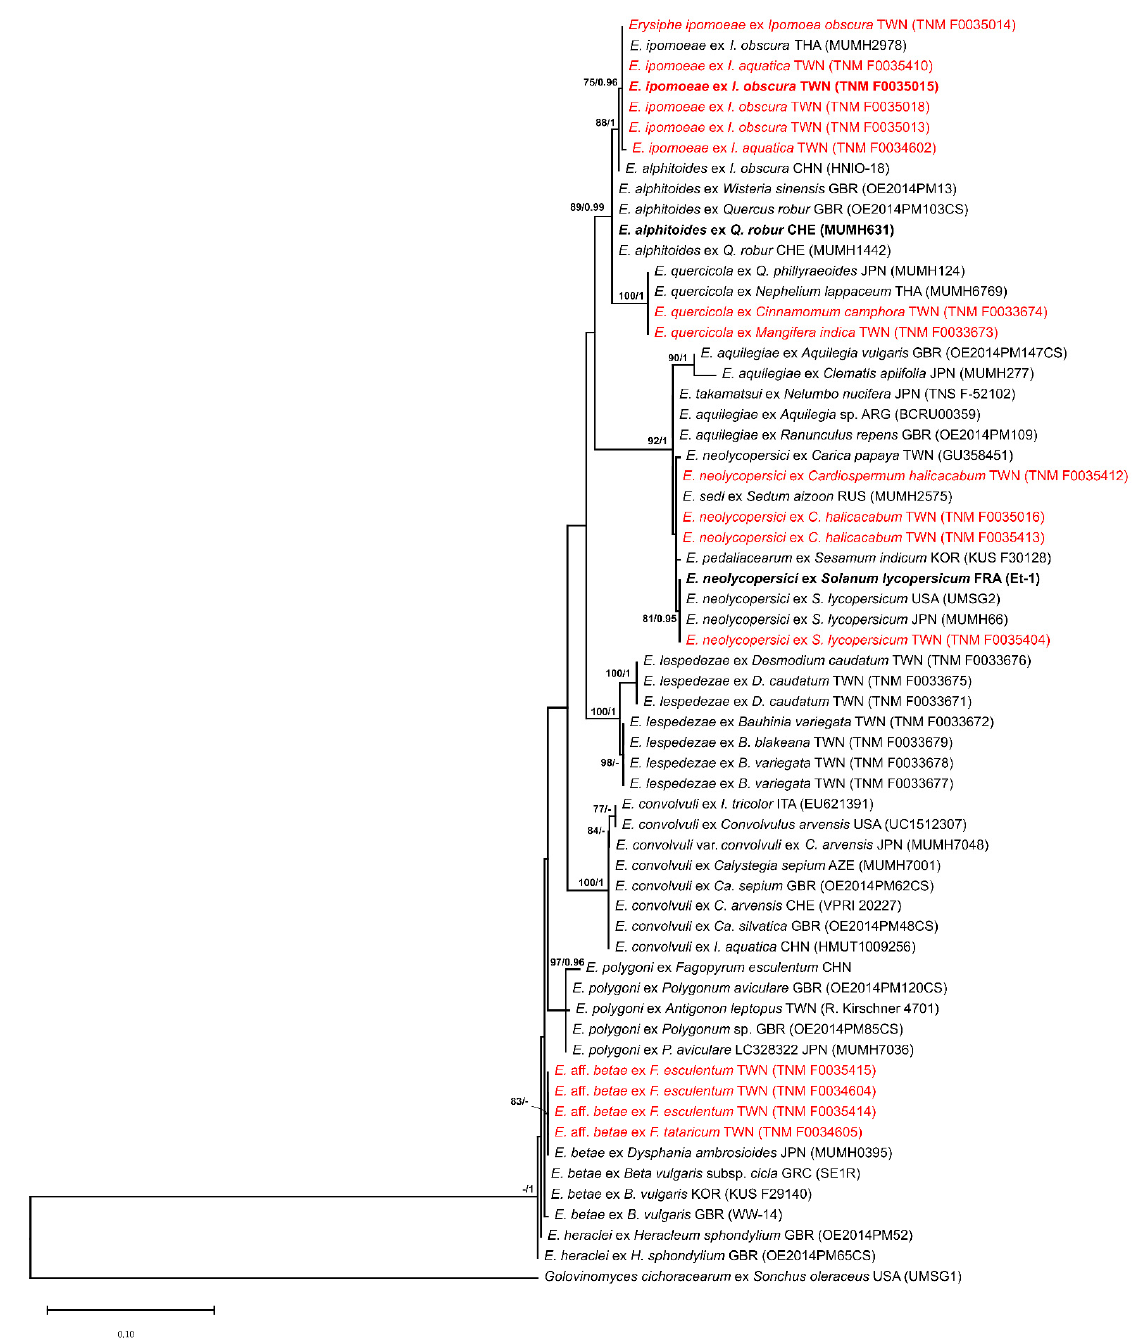
Figure 1. RAxML tree based on ITS sequences from Erysiphe . Golovinomyces cichoracearum is used as an outgroup taxon. Maximum likelihood bootstrap values ≥ 70% and Bayesian posterior probabilities ≥ 0.95 are given at the nodes. Sequences obtained in this study are shown in red. Ex-type sequences are indicated in bold.